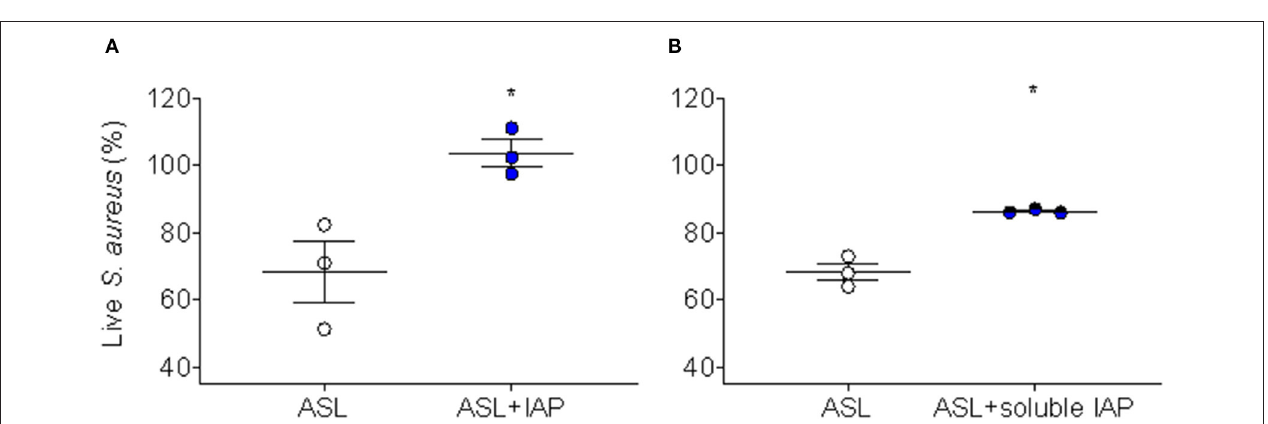
FIGURE 2 | Inhibition of ASL antimicrobial activity using NIST IAP. (A) Percent of live S. aureus remaining within 10min in the presence of ASL with and without exposure to whole-particle NIST IAP (50 µ g/mL dose), compared to percent live bacteria in vehicle (10mM NaPO 4 buffer) with particle control at the same time-point; the whole IAP significantly inhibited large HAE cell ASL bacterial killing ( p < 0.05), n = 3 from three different donors, ASL control was compared to ASL + IAP with a paired two-tailed t -test and error bars represent means and standard error of the means. (B) Live bacteria within 10min compared to t = 0min for ASL alone, and live bacteria within 10min in the presence of the soluble portion of NIST IAP (50 µ g/mL dose initial ) was compared to t = 0min at the same condition; the soluble portion of IAP significantly inhibited large HAE cell ASL bacterial killing ( p < 0.05), n = 3 from three different donors. Error bars represent means and standard error of the means. Paired, two-tailed t -tests were used to compare the percent of live bacteria within 10min to live bacteria at the initial reading (0min), as the soluble portion did not have physical particles to interfere with RLUs, * p < 0.05.